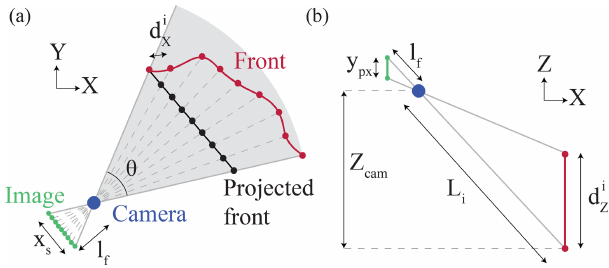
Figure 4. Schematic of the size calculation (a) in the horizontal direction and (b) in the vertical